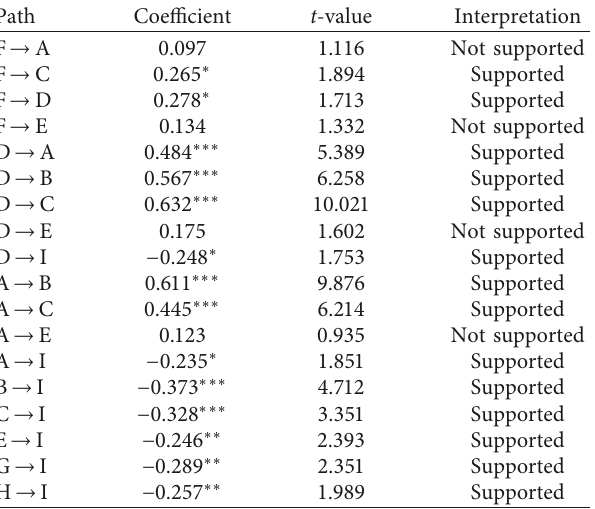
Table 5: Path coefficients and